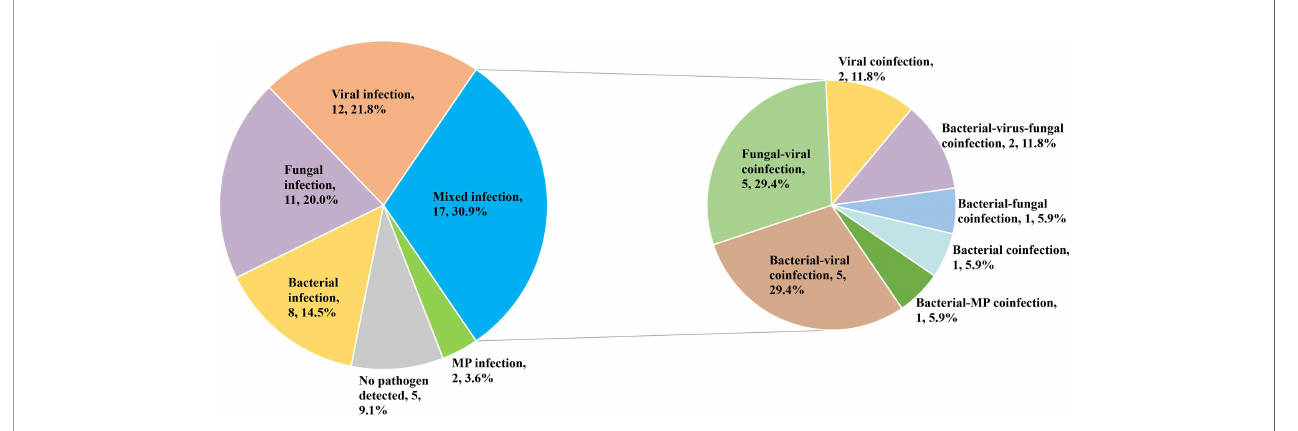
FIGURE 2 | Percentage of patients with mixed infection for various pathogens. MP, Mycoplasma pneumonia.